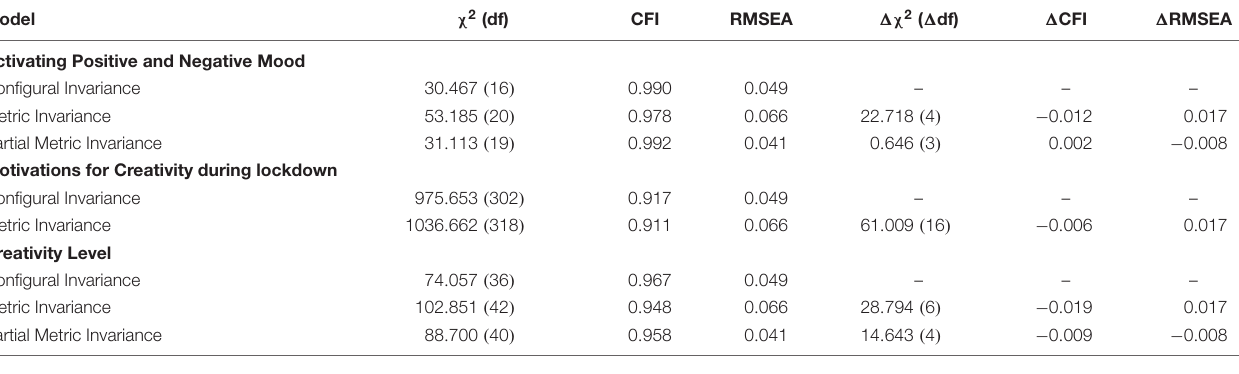
TABLE 4 | Descriptive statistics, correlations and reliability of